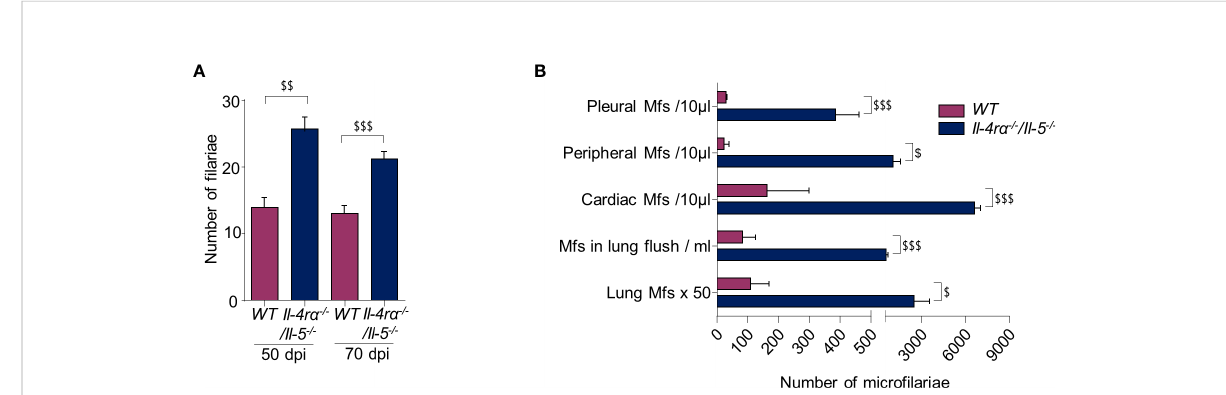
FIGURE 1 The absence of IL4R/IL5 signaling promotes fi larial survival and production of micro fi laria. WT and Il-4r a -/- /Il-5 -/- BALB/c mice were infected with L. sigmodontis and parasitic load was determined at 50 and 70 days post infection (dpi). (A) Number of adult worms in the pleural cavity; results are expressed as mean ± SEM. n=9 WT and n=9 Il-4r a -/- /Il-5 -/- mice at 50 dpi and n=24 WT and n=24 Il-4r a -/- /Il-5 -/- mice at 70 dpi, pool of 1-3 experiments. (B) Number of micro fi lariae (Mfs) in pleural cavity fl uid (n=8 per group of mice), in peripheral blood (n=24 per group of mice), in cardiac blood (n=24 per group of mice), in pulmonary fl ush (n=8 per group of mice) and in the whole lung tissue (n=5 per group of mice). For each location a t-test was performed $ p<0.05, $$ p<0.01 and $$$ p<0.001 represent differences between WT and Il-4r a -/- /Il-5 -/-